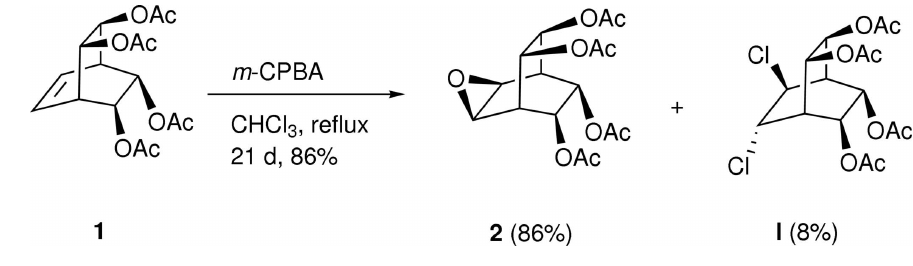
The formation of the title